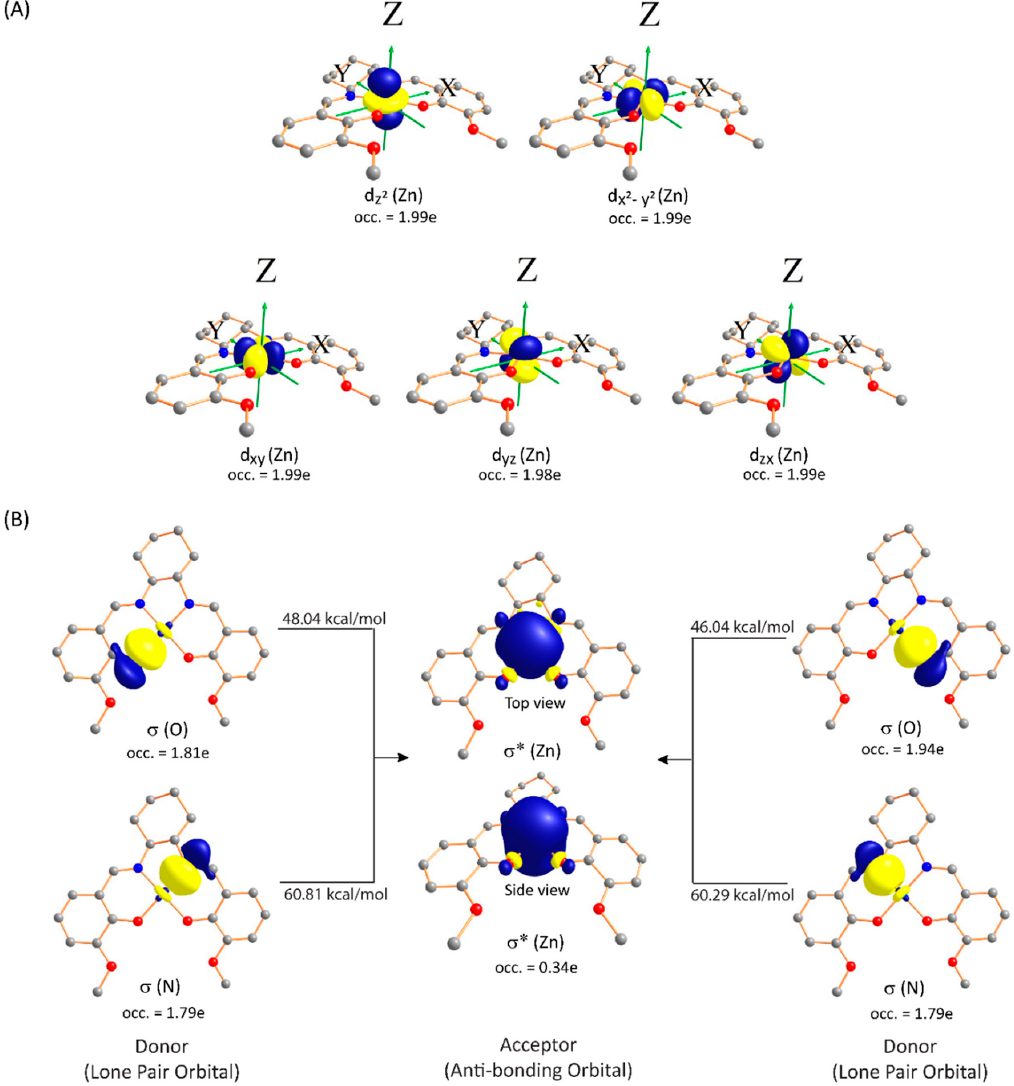
Figure 4. ( A ) Selected metal centered natural bond orbitals (NBOs) of [Zn(sal)](H 2 O), and ( B ) LP → LP* donor–acceptor orbitals interaction derived from NBO analysis of [Zn(sal)](H 2 O) (monomeric form). Hydrogen atoms are omitted for clarity (isovalue = 0.03).